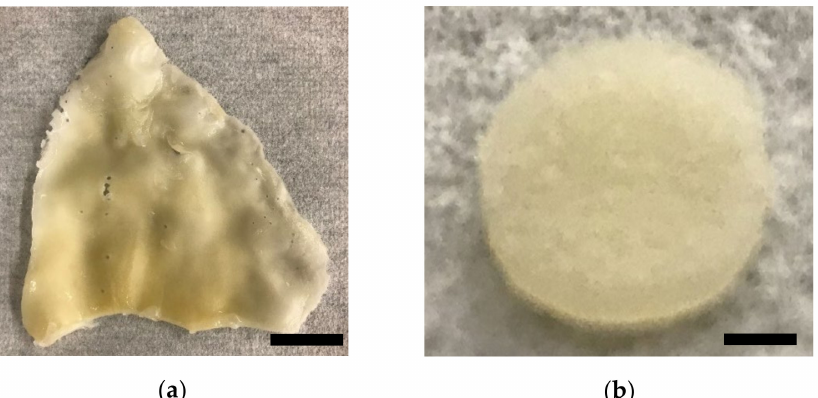
Figure 1. Cartilage scaffold resulting from decellularization process: ( a ) porcine auricular cartilage after dissection and initial processing; ( b ) 8 mm diameter cartilage disc after decellularization process was complete. Discs of decellularized cartilage were formed using an 8 mm diameter biopsy punch. Scale bars: ( a ) 30 mm; ( b ) 2 mm.